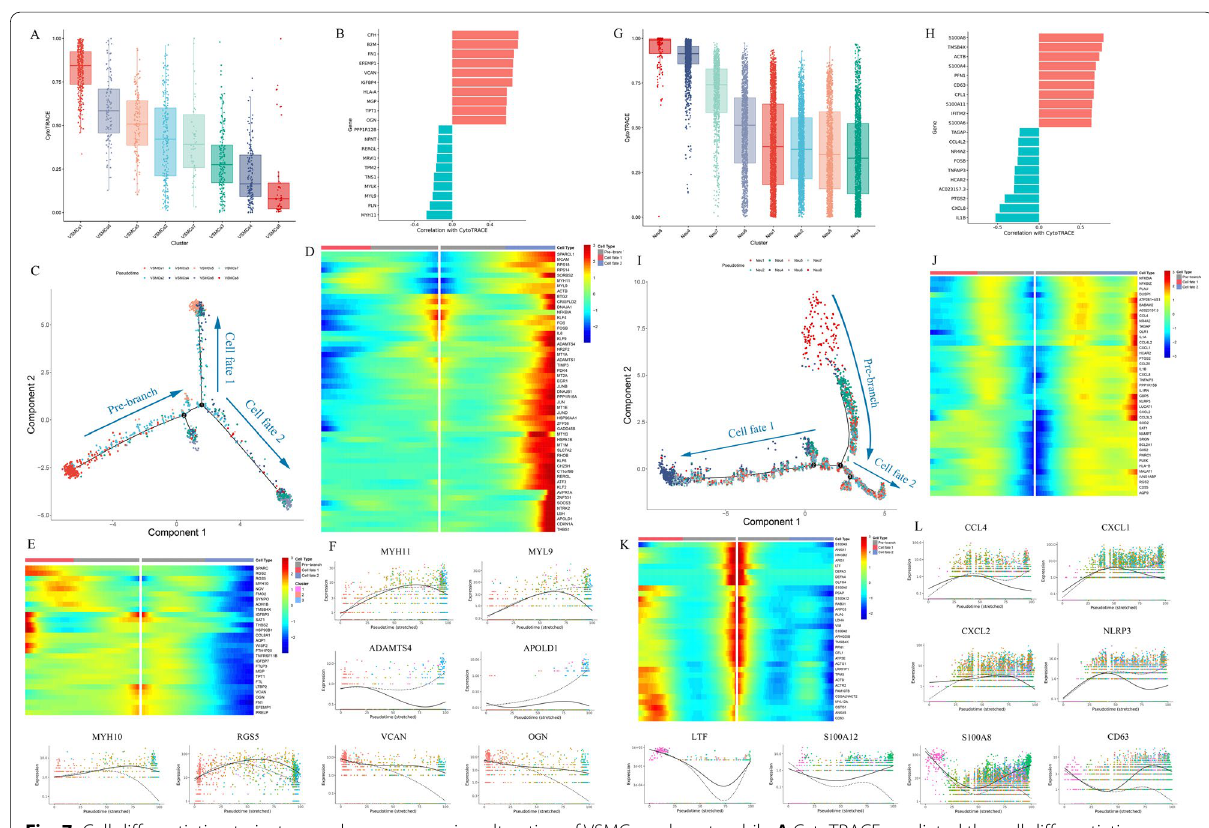
Fig. 7 Cell differentiation trajectory and gene expression alteration of VSMCs and neutrophils. A CytoTRACE predicted the cell differentiation potential of VSMCs. B Genes correlated with more differentiated and less differentiated VSMCs predicted by CytoTRACE. C Pseudo‑time analysis showed the cell differentiation trajectory of VSMCs based on selecting VSMCs 1 as the initiate. D , E heatmap of gene expression alteration relating to D ECM organization, cell adhesion and E response to stimulus. F Alteration curves of representative genes. The full line represented cell fate 1, the dashed line represented cell fate 2. G CytoTRACE predicted the cell differentiation potential of neutrophils. H Genes correlated with more differentiated and less differentiated neutrophils predicted by CytoTRACE. I pseudo‑time analysis showed the cell differentiation trajectory of neutrophils upon selecting Neu 8 as the initiate. J , K heatmap of gene expression alteration relating to J chemotaxis, inflammatory and immune response and K cellular component movement. L Alteration curves of represented genes. The full line represented cell fate 1, the dashed line represented cell fate